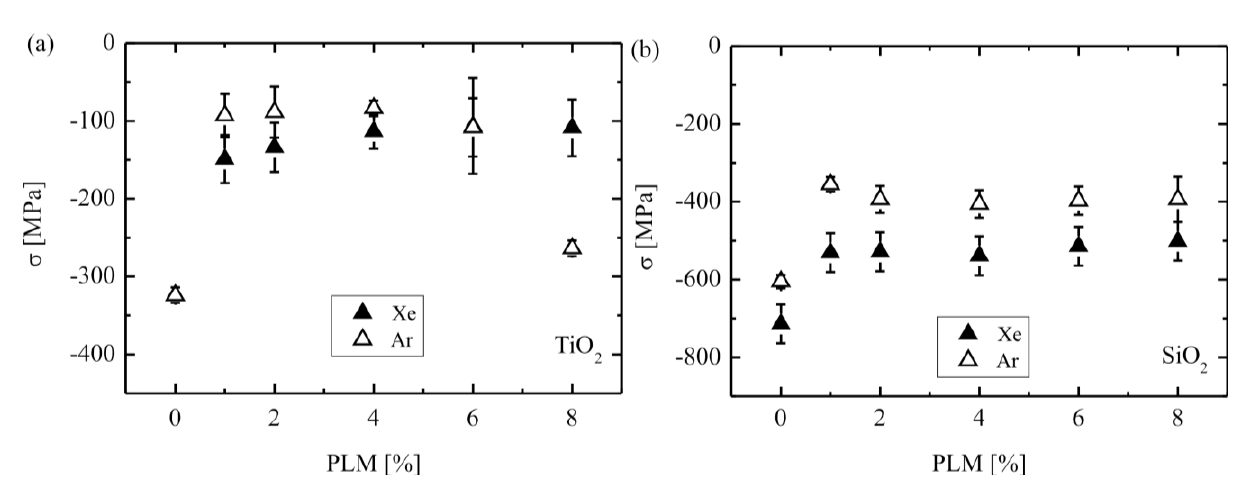
Figure 18 . Film stress versus pulse length modulation of the assisting ion beam for (a) TiO and (b) SiO films grown with an ion energy of 1.2 keV of the assist ion beam. 2 2 PLM indicates the pulse length modulation of the assist ion beam